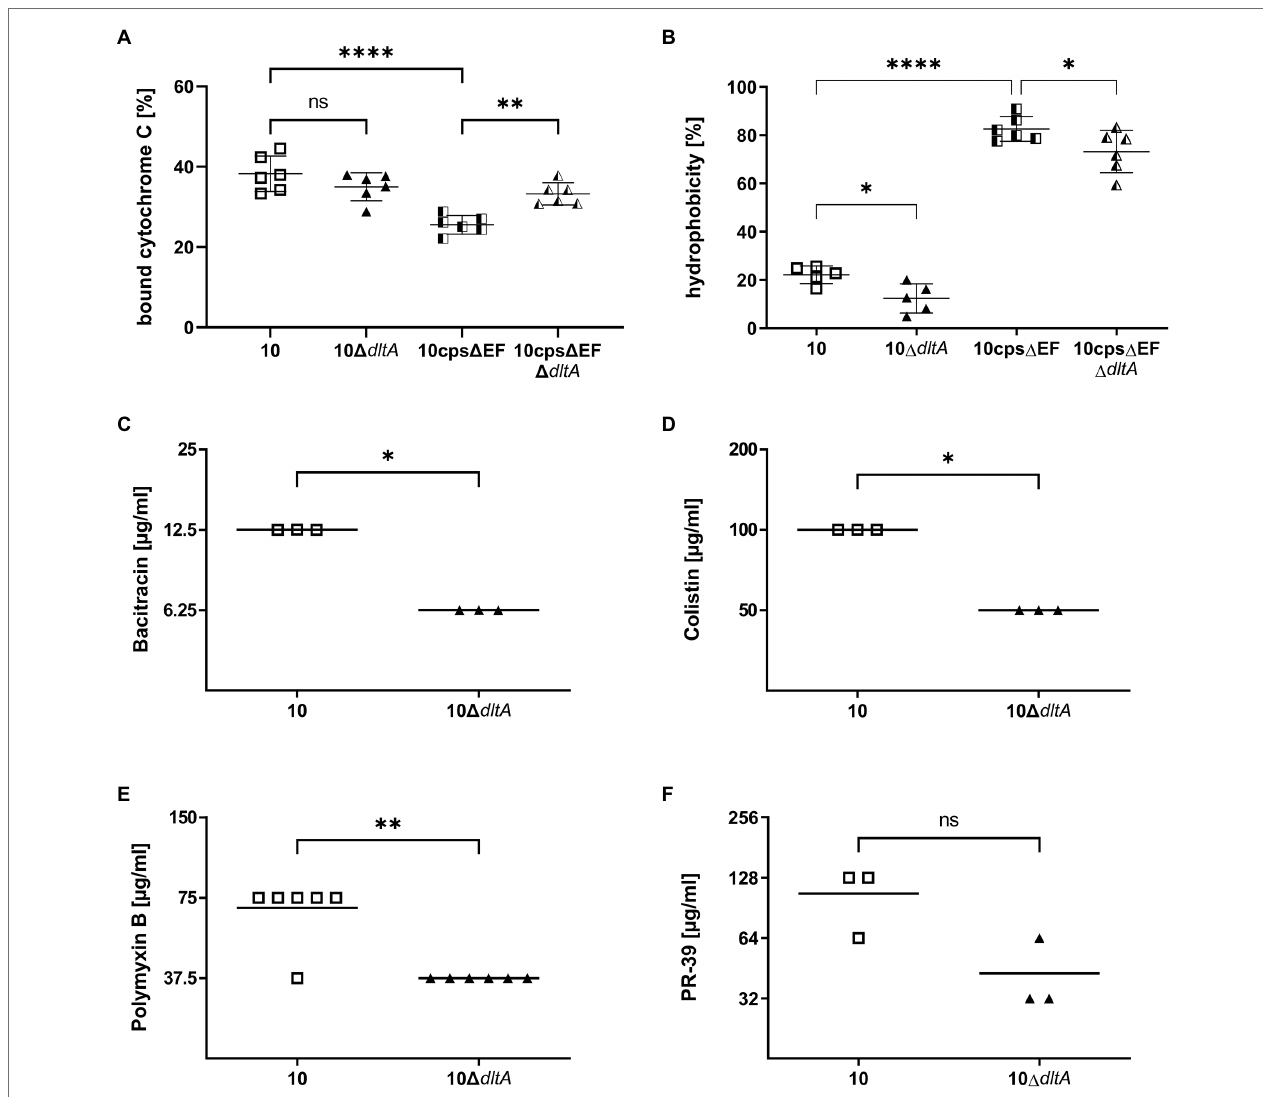
FIGURE 1 | D-alanylation of lipoteichoic acids (LTAs) increases the ability to bind cationic cytochrome C in the absence of the capsule in Streptococcus suis , reduces the hydrophobic character of the streptococcal surface, and provides protection against several cationic antimicrobial peptides (CAMPs). Binding of the cationic cytochrome C (Cyt C) to the bacterial surface (A) was evaluated indirectly by photometrical measurement of the bacterial supernatants after 10 min of incubation with 0.5 mg/ml Cyt C in morpholinepropanesulfonic acid (MOPS) buffer, compared to a control containing 0.5 mg/ml Cyt C without bacteria. (B) Shows the hydrophobicity of S. suis strains, as evaluated by rigorous mixing of bacterial PBS suspensions (adjusted to OD 600 of 1) with the hydrophobic solvent hexadecane. The mixtures were left to settle for 30 min followed by measuring the OD 600 of the aqueous (PBS) phase and calculation of the hydrophobicity as written in the materials and methods section. (C–F) Demonstrate minimal bactericidal concentrations (MBC) that were evaluated by incubating S. suis strain 10 or 10 Δ dltA (1 × 10 4 CFU/ml) in a 2-fold serial dilution of the antimicrobial agent for 24 h at 37 ° C and subsequently plating on blood agar plates. MBC was defined as the lowest concentration of the antimicrobial agent where no bacterial growth occurred on agar plates. Each symbol represents a measurement in triplicates and each experiment was repeated at least three times with freshly cultured bacteria. Assays were performed in Todd-Hewitt broth (THB; C,D,E ) or Rosewell Park Memorial Institute (RPMI) with 5% cation-adjusted Mueller Hinton broth (CA-MHB; F ). One-way ANOVA was performed followed by Holm-Sídáks multiple comparisons test and results are indicated for the comparisons of each isogenic mutant to its parent strain (A,B) . One-tailed Mann–Whitney test was performed to compare wild-type (wt) and dltA mutant samples in (C–F) . Not significant (ns) p ≥ 0.05, * p < 0.05, ** p < 0.01, and **** p <